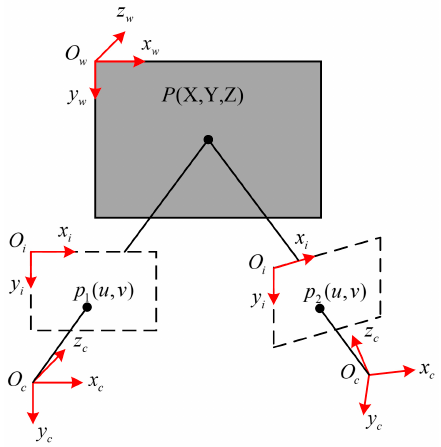
Figure 1. Flow chart of finite element model correction method.